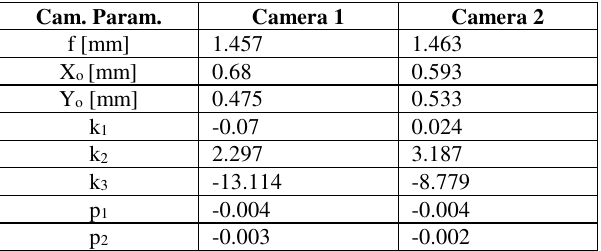
Table 3. Estimated values of intrinsic parameters